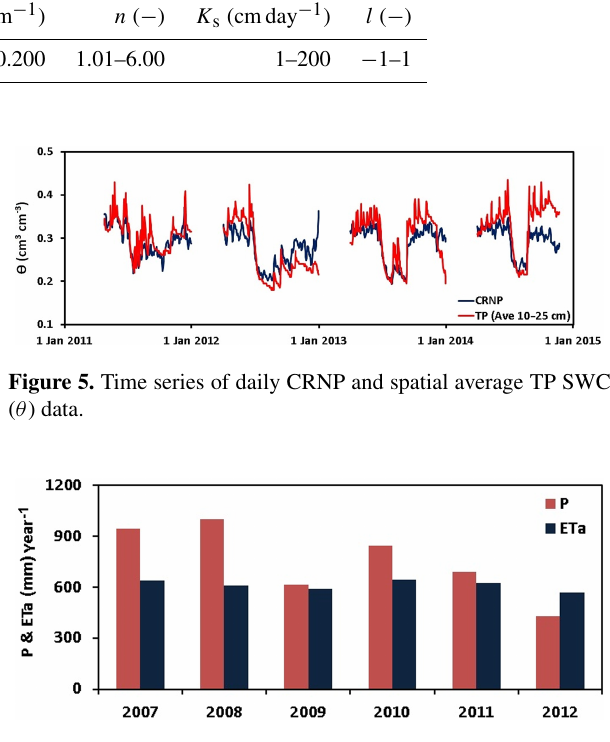
Figure 6. Annual precipitation ( P ) and annual actual evapotranspi- ration (ET a ) at the Mead rain-fed (US-Ne3)